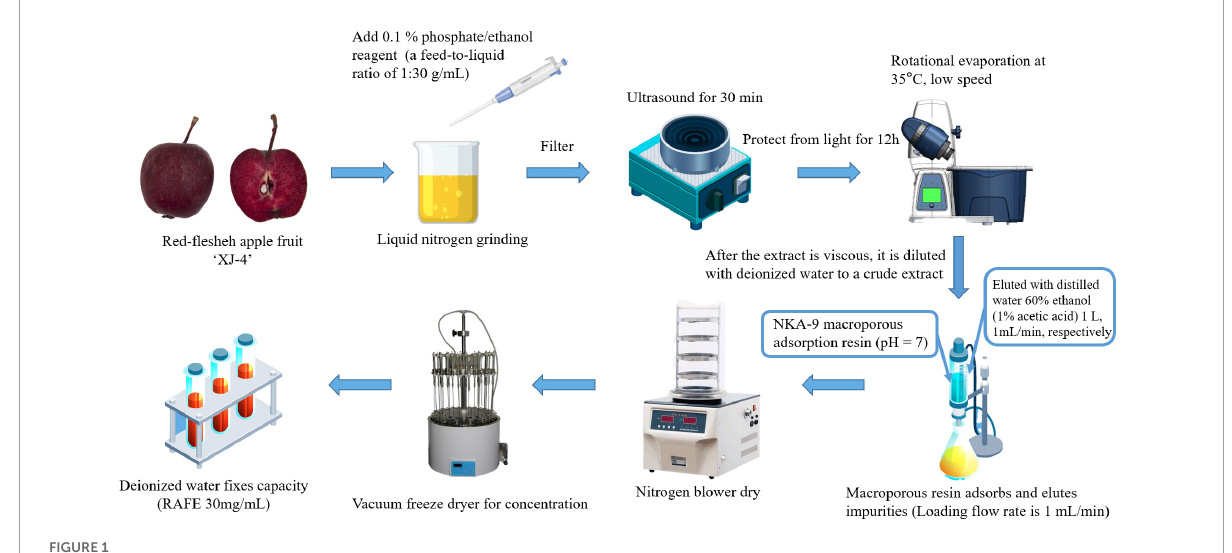
FIGURE1 Process flow chart of ‘XJ4’ RAFE preparation and